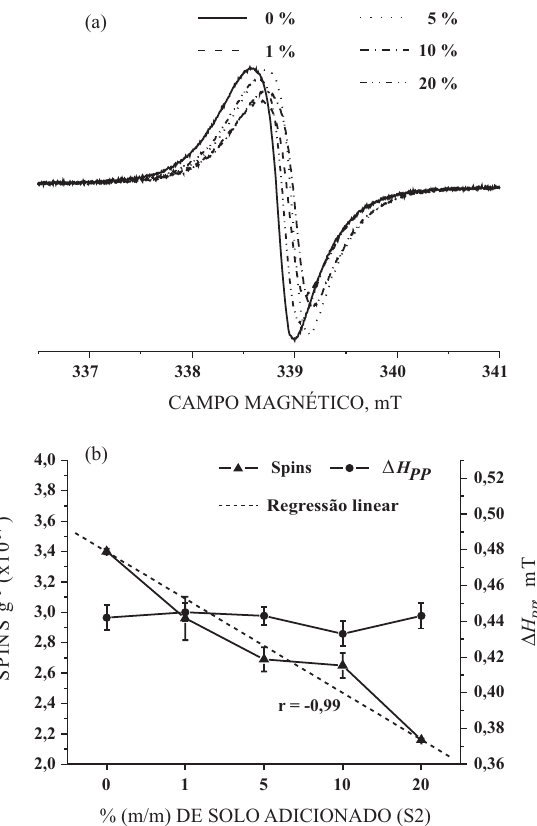
Figura 4. Espectros de RPE da amostra 6 com diferentes porcentagens (m/m) de solo adicionado (S2) à amostra (a). Concentração de RLO (em spins g -1 de amostra) e largura de linha do sinal ( ΔΔΔΔΔ H ) de acordo com a porcentagem PP de solo adicionado à mesma amostra (b). A Figura 5. Espectros de RPE da amostra 6, da regressão linear está associada à concentração amostra 6 + 10 % (m/m) de solo (S2) e somente de RLO e à porcentagem de solo adicionado. de